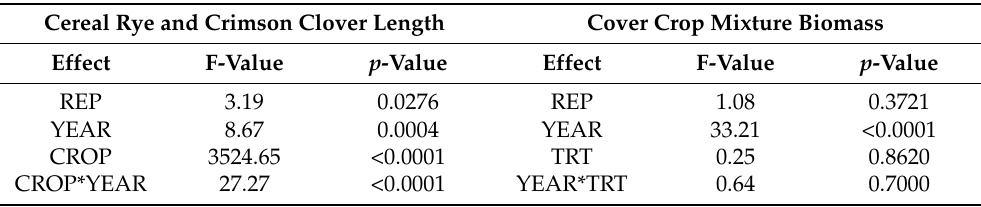
Table 3. ANOVA results with respect to cover crop plant length and biomass